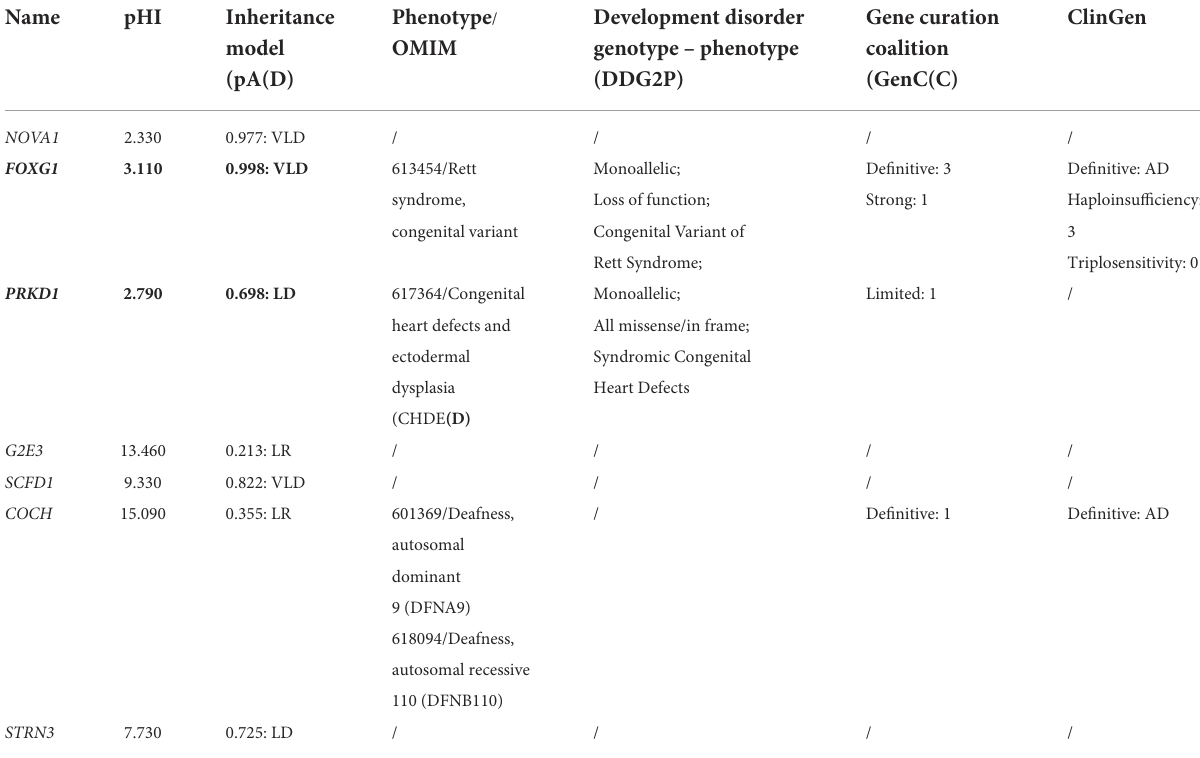
TABLE 2 Haploinsufficiency predictions for the 7 shared genes in microdeletions of three